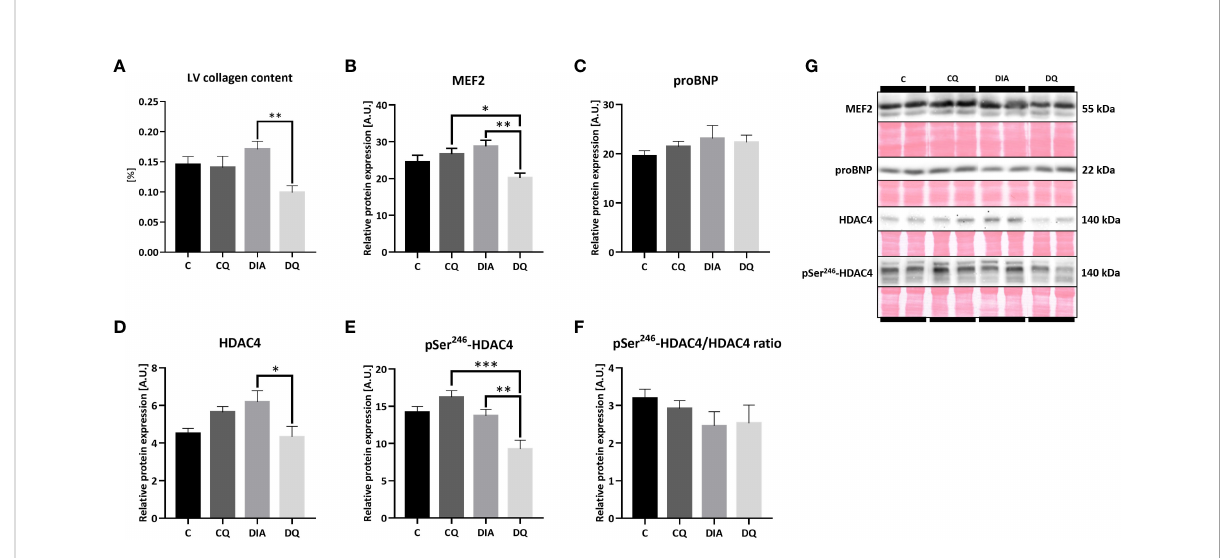
FIGURE 3 (A) LV total collagen content determined by hydroxyproline assay. (B – F) Western blot analysis of relative protein expression of (B) myocyte enhancer factor-2 (MEF2), (C) pro B-type natriuretic peptide (proBNP) (D) histone deacetylase 4 (HDAC4), (E) pSer 246 -HDAC4 and (F) pSer 246 - HDAC4/HDAC4 ratio. (G) Representative Western blots of detected proteins with estimated molecular weight (kDa) compared to total protein staining with Ponceau S. Data are presented as mean ± SEM and statistical differences as * p < 0.05, **p < 0.01, *** p < 0.001 (one-way ANOVA paired with Tukey´s multiple comparisons